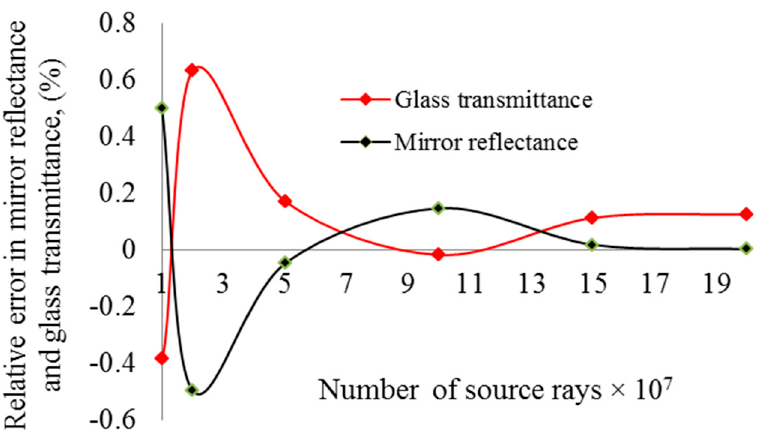
Figure 3. Optimum number of source rays per square meter aperture area, N ray . Error = {(True value − MCRT calculated value) × 100%}/(True value). True value for mirror reflectance was 0.93 and for glass transmittance was 0.95.